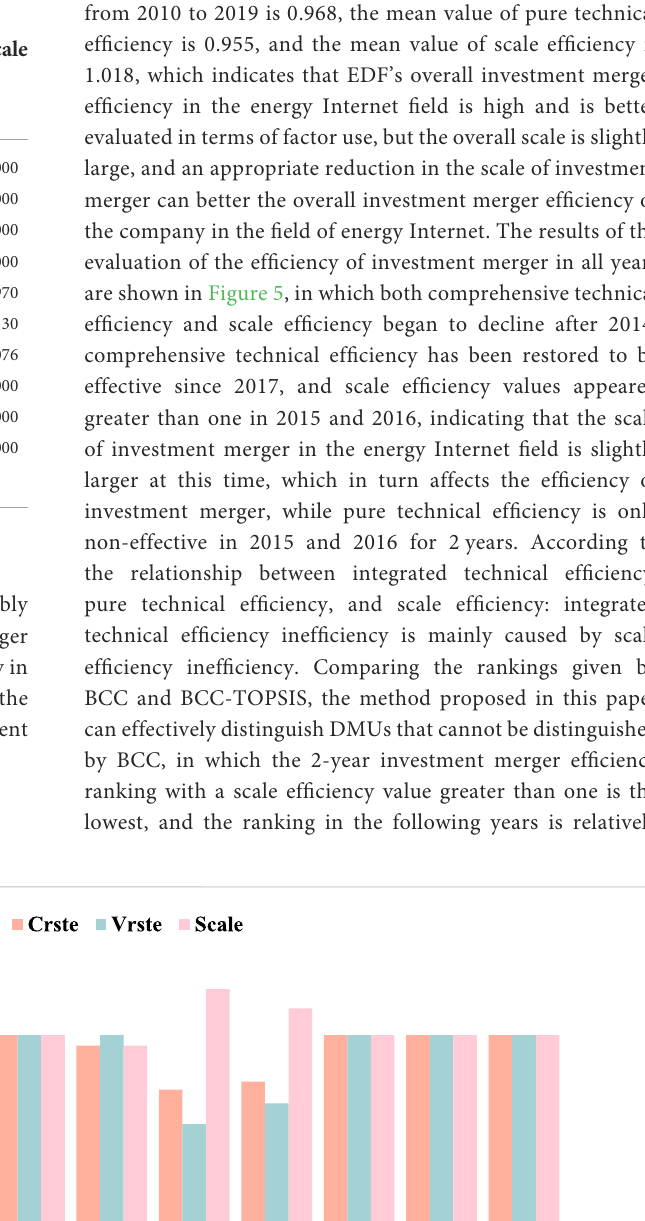
TABLE 5 Integration of investment and merger ef fi ciency evaluation results-EDF.